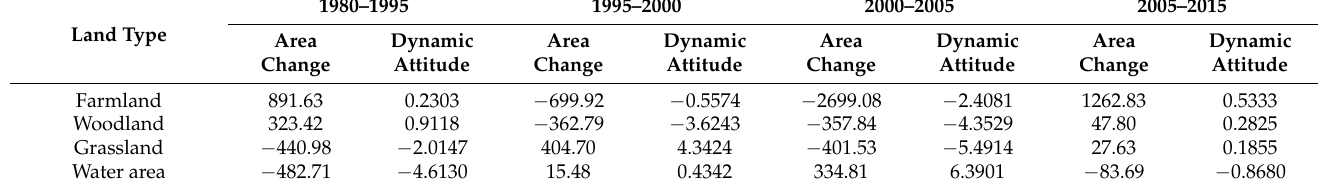
Table 1. Degree of spatial dynamics of land use types in different periods between 1980 and 2015 (unit: km²).